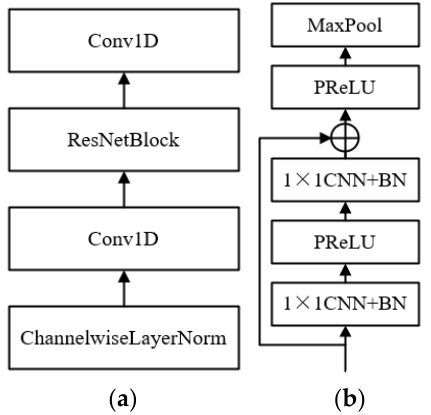
Figure 6. Internal structure diagram of the auxiliary network. ( a ) Music extractor ( b ) ResNetBlock.